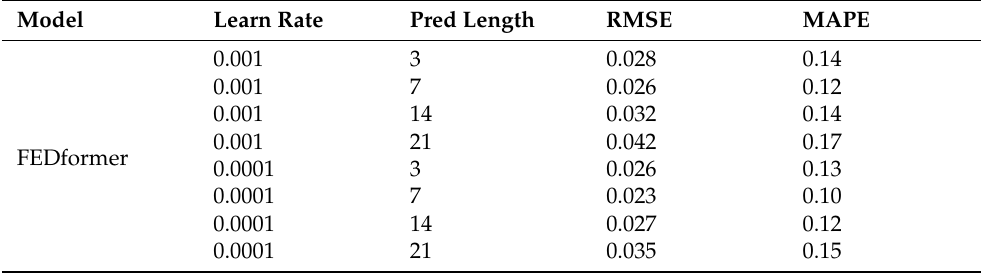
Table 2. Parameter setting for FEDformer-based model for predicting quality changes in grain storage processes. Model